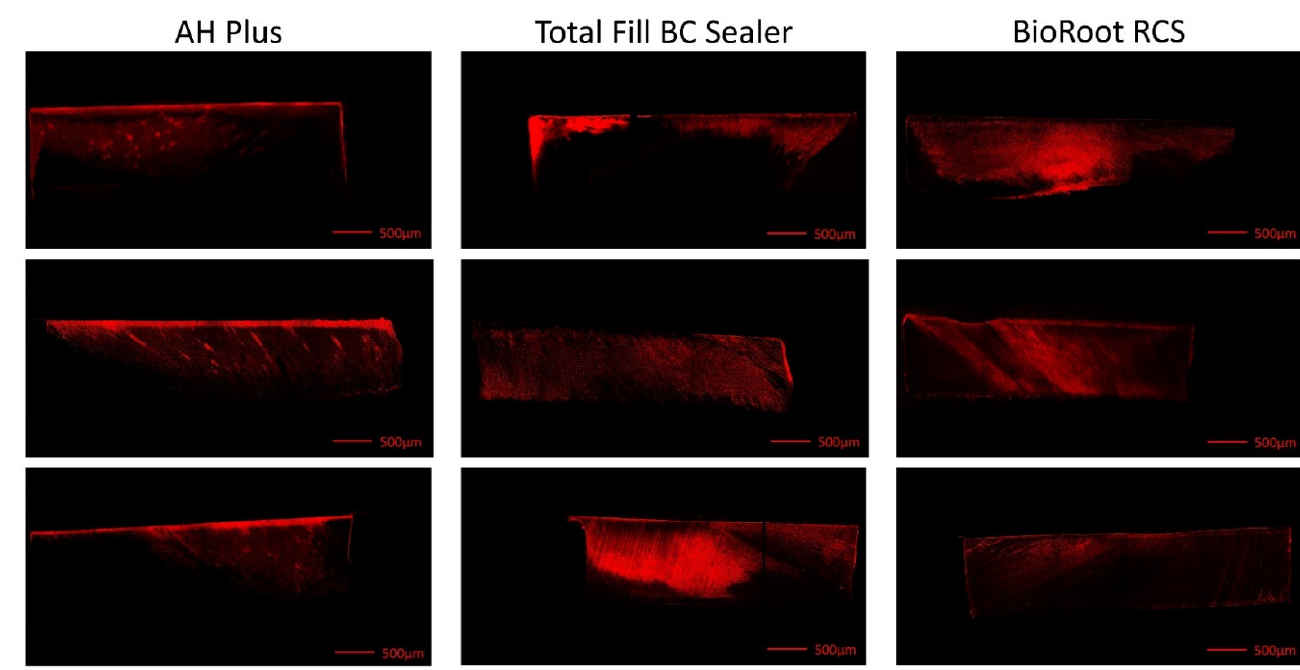
Figure 1. Photographs of the sealers AH Plus, Total Fill BC Sealer, and BioRoot RCS ( n = 3 per sealer) at T 0 (sealers mixed with rhodamine B) and T 1 (sealer after contact with PBS for 7 days). AH Plus was not stained red by rhodamine B dye under dry conditions, while Total Fill BC Sealer and BioRoot RCS presented in a pink color directly after mixing. After the exposure of AH Plus to PBS, the surface turned red. Total Fill BC Sealer and BioRoot RCS lost their coloration after contact with PBS, and the buffer solution turned to a pink color.